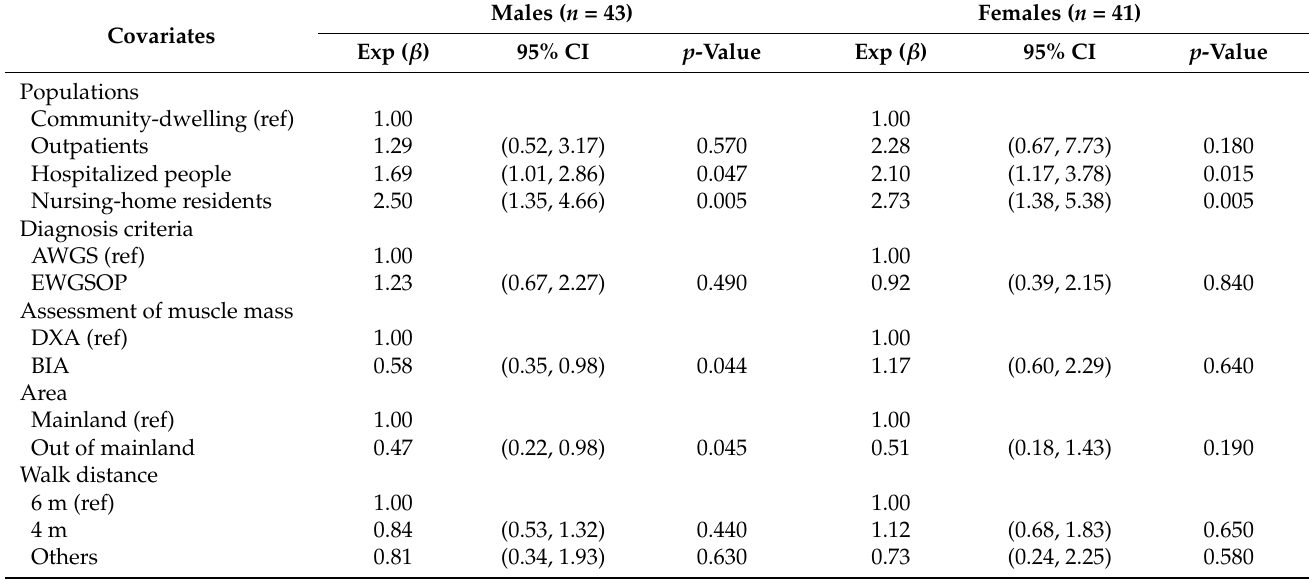
Table 2. Multivariable